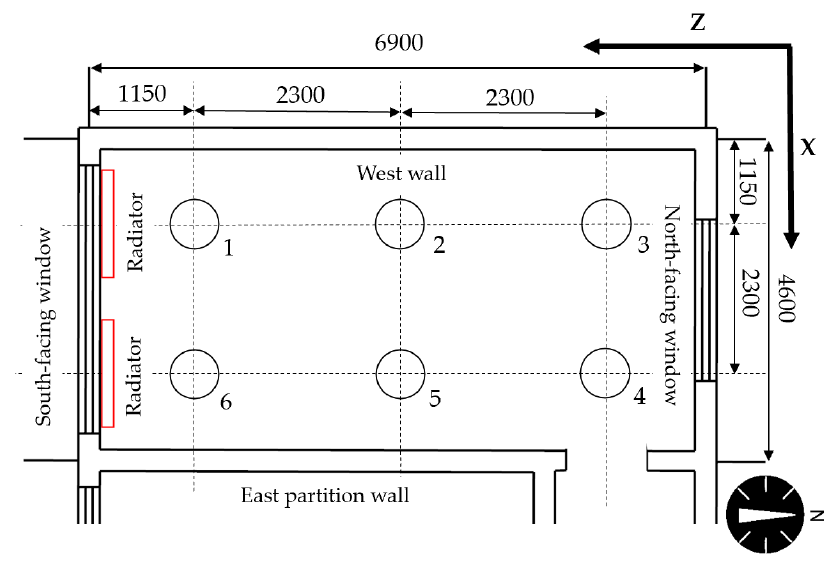
Figure 13. The human body positions in the office room.